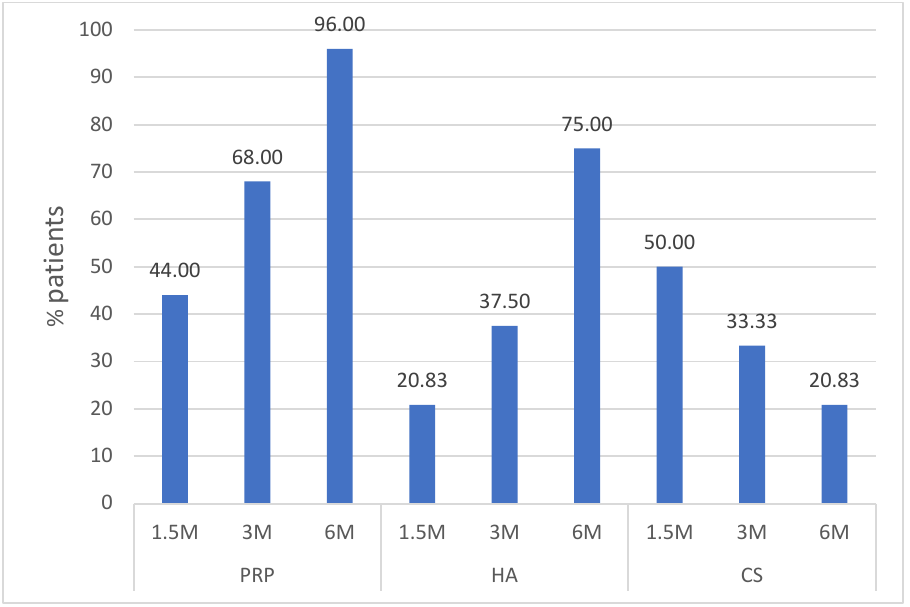
Figure 6. Clinically important improvement.